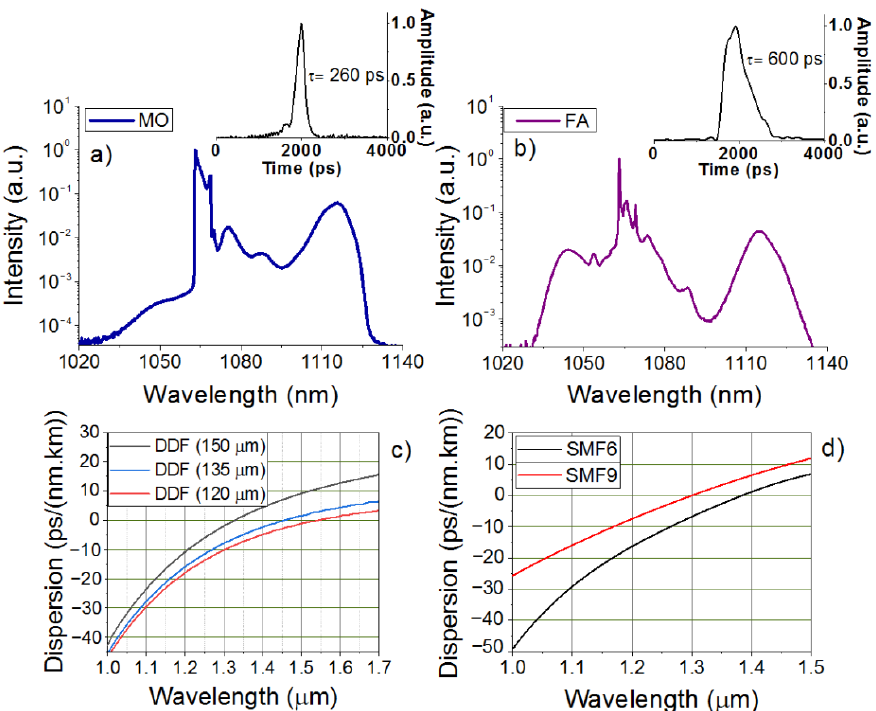
Figure 2. The output parameters of the MO ( a ) with subsequent conversion of its characteristics after using a fiber amplifier ( b ), as well as graphs of the dispersion for different diameters of DDF ( c ) and SMF ( d ).